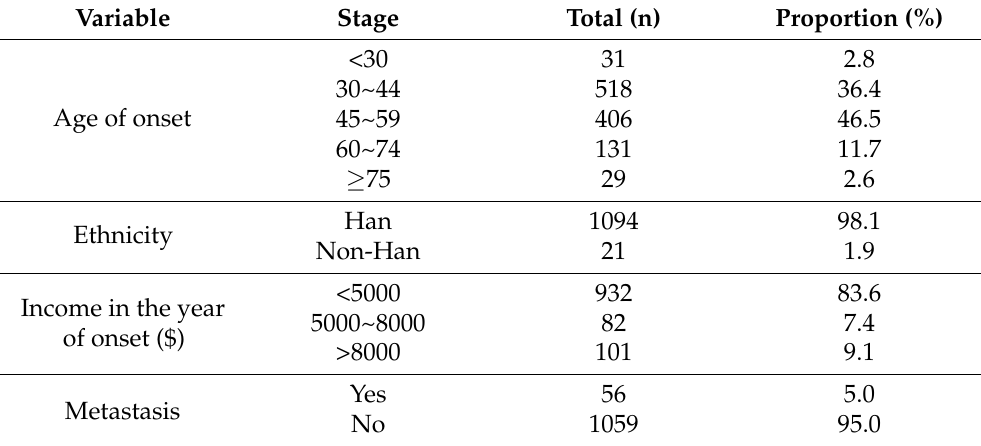
Table 1. Demographic characteristics of cervical cancer cases.